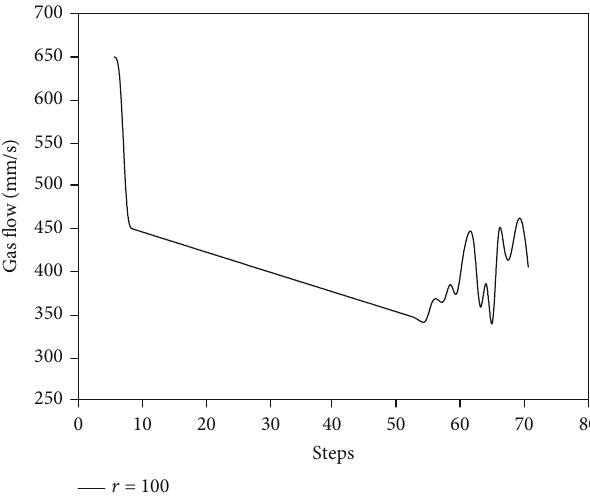
Figure 4: Coordinates (175,190) unit gas fl ow change curve.